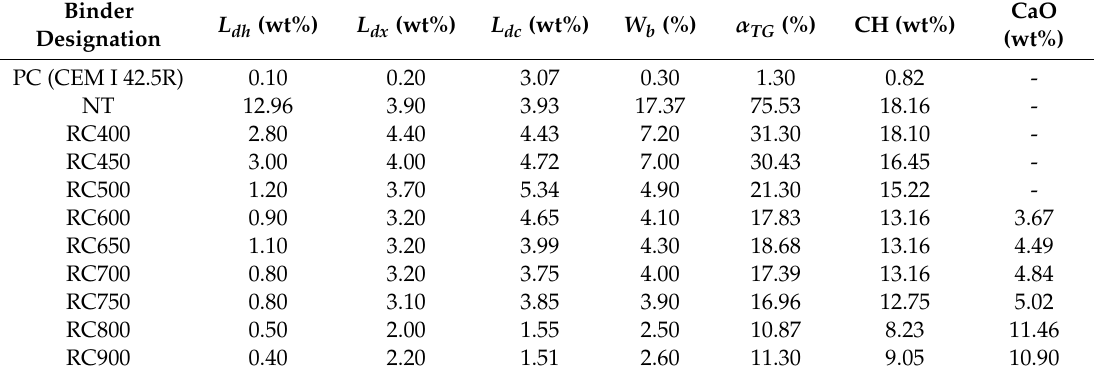
Table 3. Estimated L dh , L dx , L dc , W b , α TG , CH and CaO contents of PC, NT and RC treated at di ff erent